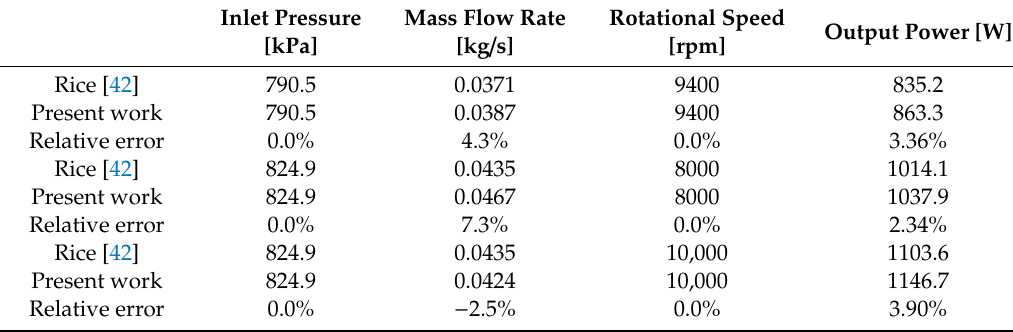
Table 4. Comparison of present work numerical results with Rice [42].